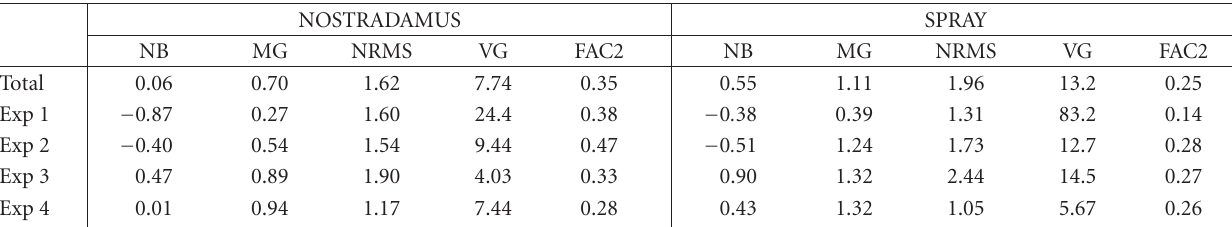
Table 6: Statistical criteria with the temporal averaging (by time with spatial location